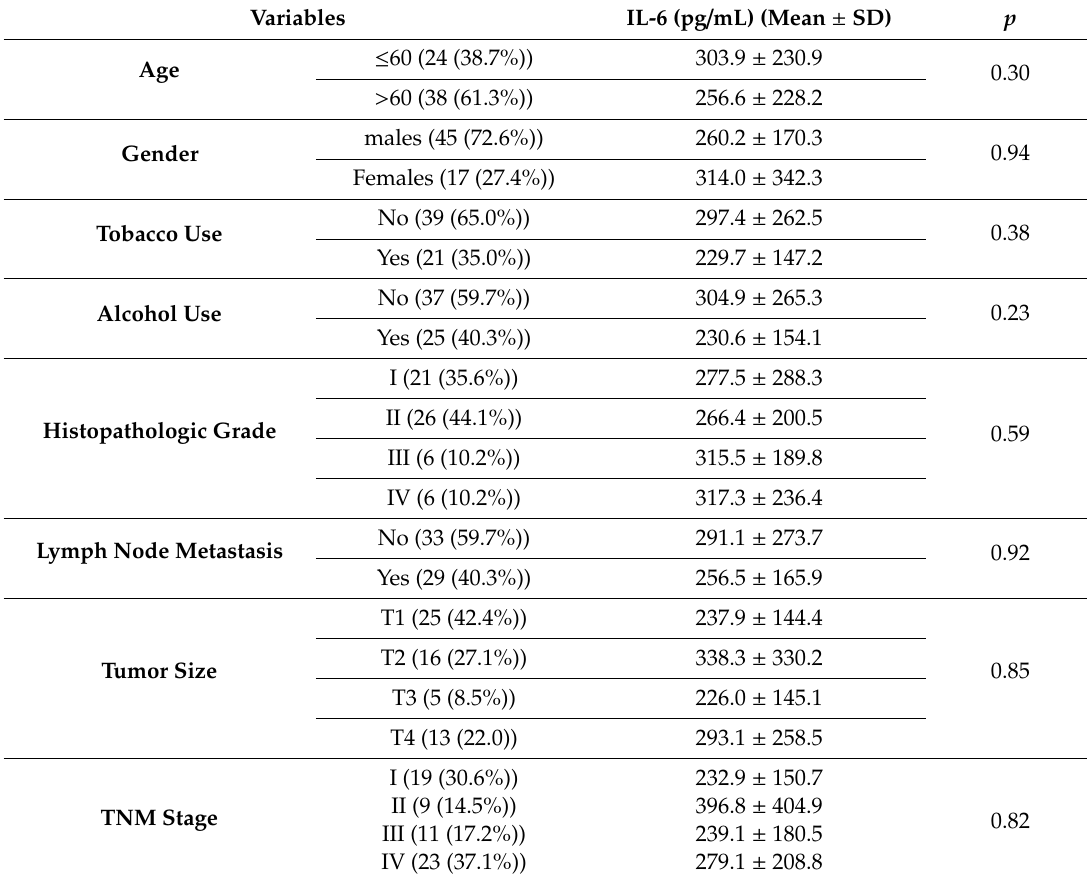
Table 3. Association between the serum levels of IL-6 and the clinicopathological features of